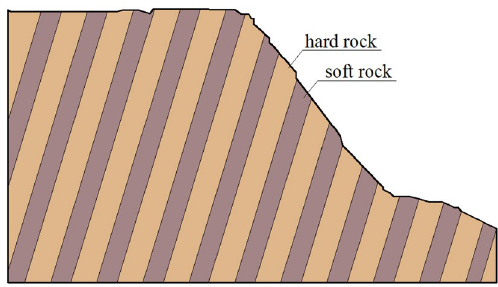
Figure 1. Schematic diagram for initial state of soft–hard-interbedded anti-inclined rock slope.